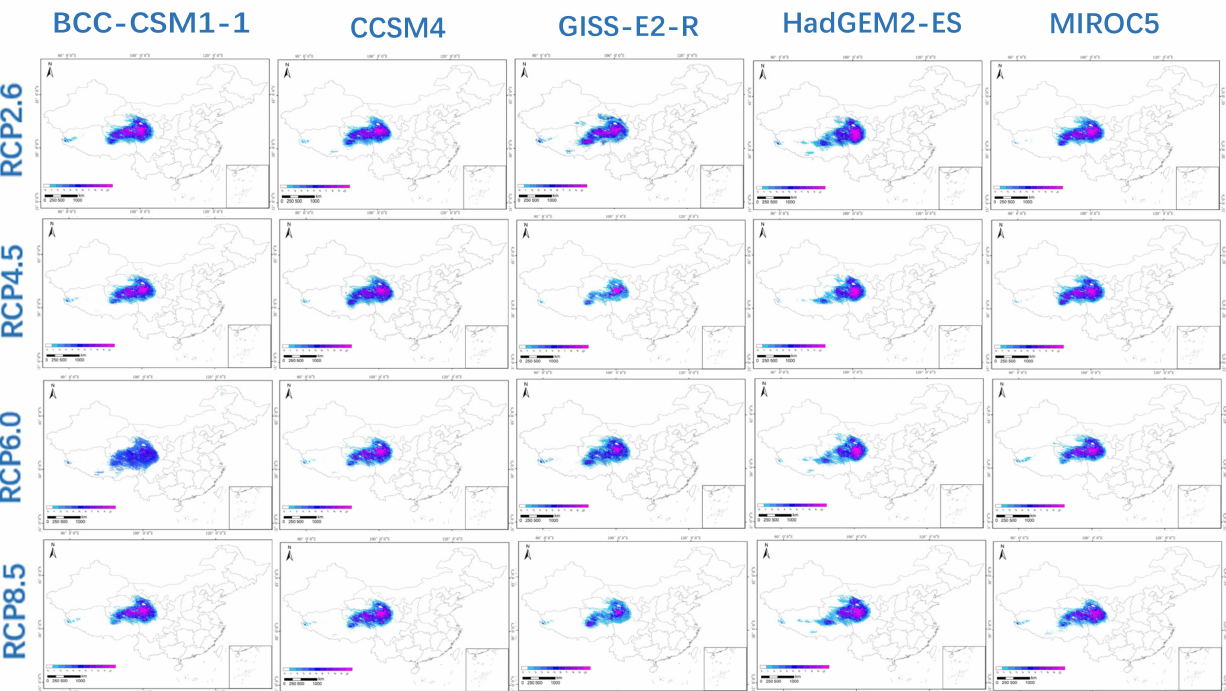
Figure 3. The habitat suitability of Pomatosace filicula population under four climate scenarios (RCP 2.6, RCP 4.5, RCP 6.0 and RCP 8.5) and five General Circulation models (BCC-CSM1-1, CCSM4, GIS-E2-R, HadGEM2-ES and MIROC) in